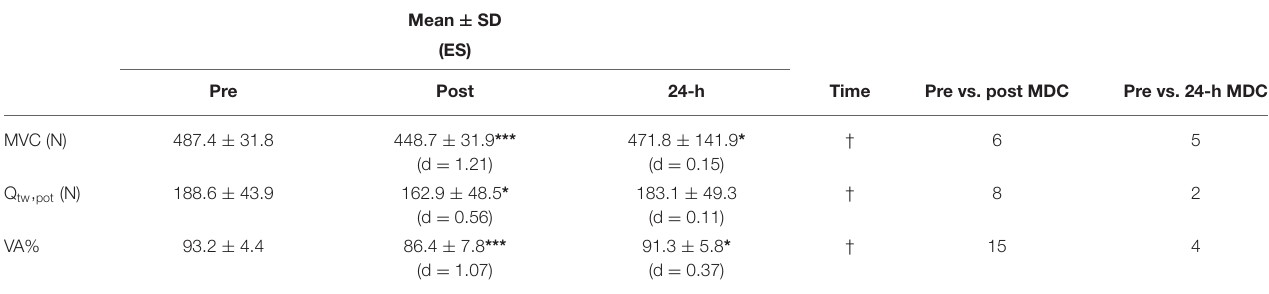
TABLE 3 | Neuromuscular function measures of maximum voluntary contraction (MVC) of the knee extensors, voluntary activation percentage (VA%), and quadriceps resting twitch potential (Q tw , pot, ,N) at pre, post, and 24-h of training run represented as mean exceeding minimum detectable change (MDC) for each variable at post and 24-h post compared to